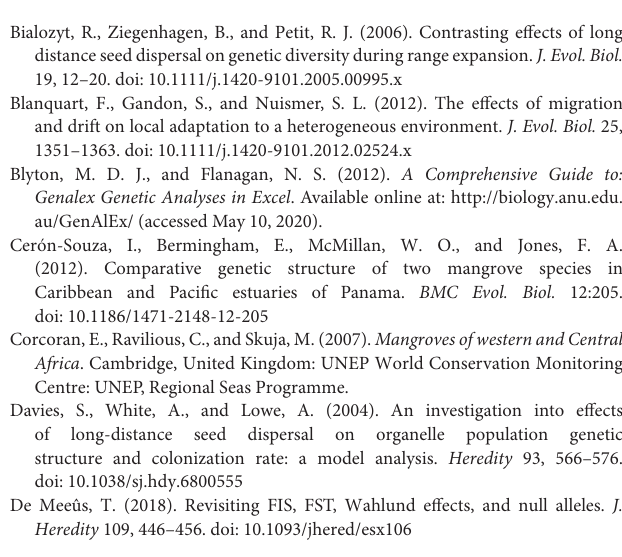
Supplementary Table S3 | Within site kinship coefficient ( F IJ ). Supplementary Table S4 | Pairwise Kinship coefficient ( F IJ ) with respect to entire